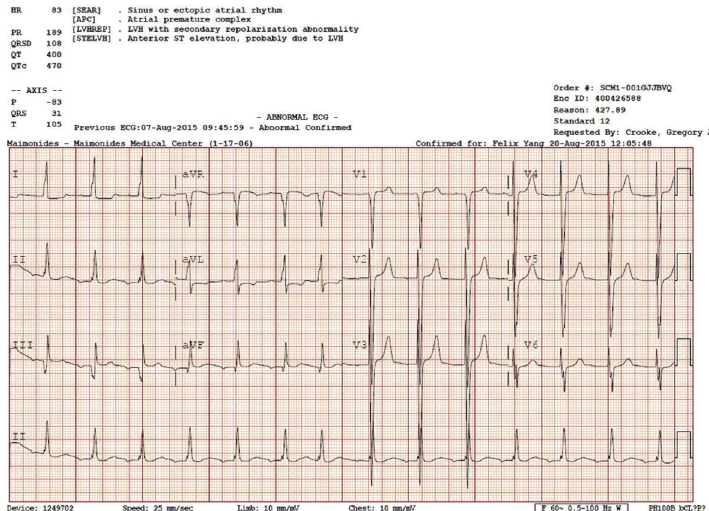
Figure 1: Electrocardiogram showed ectopic atrial rhythm, atrial premature complexes, left ventricular hypertrophy (LVH) with secondary repolarization abnormality, and anterior ST elevation, probably due to